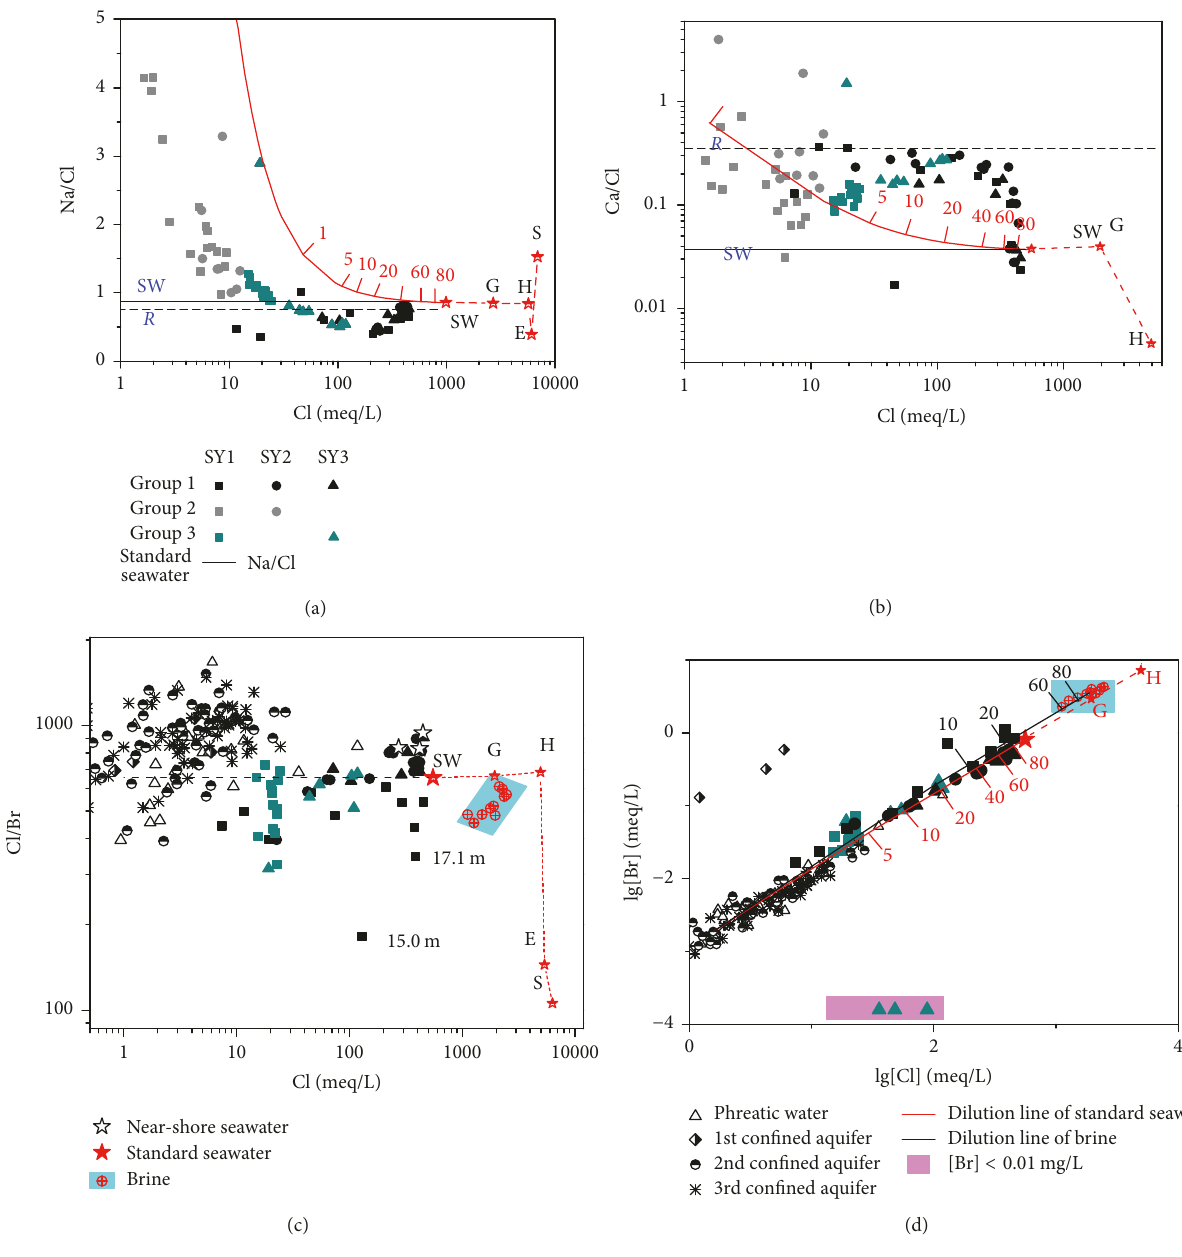
Figure 6: Evolution of hydrochemical ratios with increasing salinity of porewaters. The near-shore seawater samples were given by Fu [22]. Brine samples were collected from Han et al. [10]. 𝑅 indicates ratios in rainwater, based on data from Zhang et al. [51]. The seawater dilution line between standard seawater and fresh aquifer groundwater is illustrated in red line, and the numbers along with the mixed line stand for the percentage (%) of seawater mixing. The seawater evaporation trajectory (red dashed line) was given by Fontes and Matray [52]; SW, G, H, E, and S represent points of standard seawater, precipitation of gypsum, halite, epsomite, and sylvite,